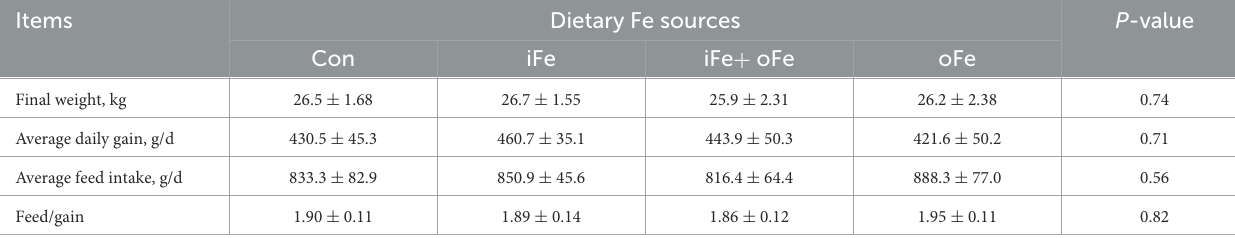
TABLE 3 Effects of different iron sources on growth performance of weaned piglets from d 28 to d 70. Items